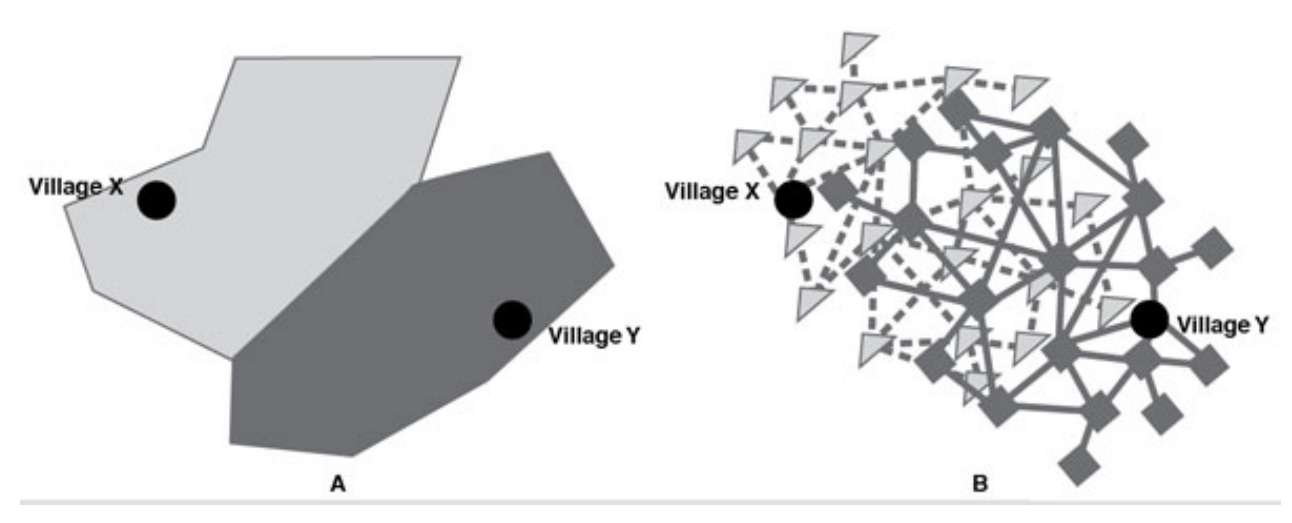
Fig. 1 . Schematic view of sites and forest trails across two